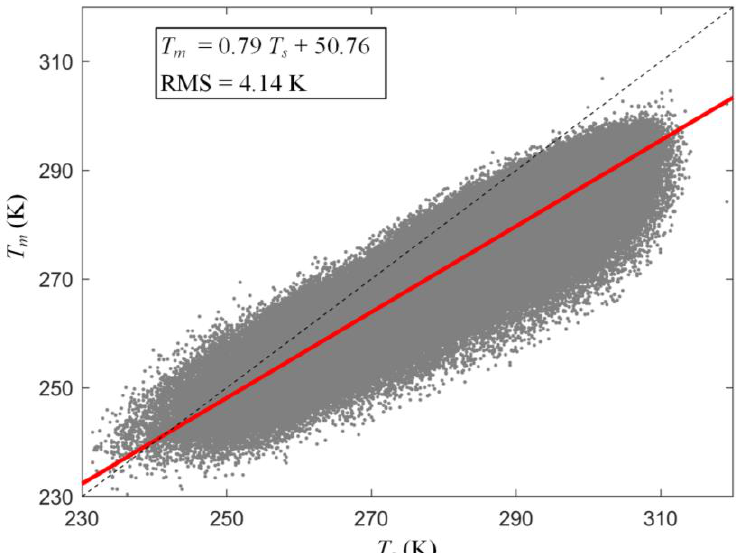
Figure 2. Relationship between T m and T s determined from 860,054 radiosonde profiles over China. The radiosonde profiles are acquired from the 88 stations (Figure 1) between 2005 and 2018. The red solid line is the linear regression result of the data (the unified model), and the black dotted line shows the positions where T m and T s are